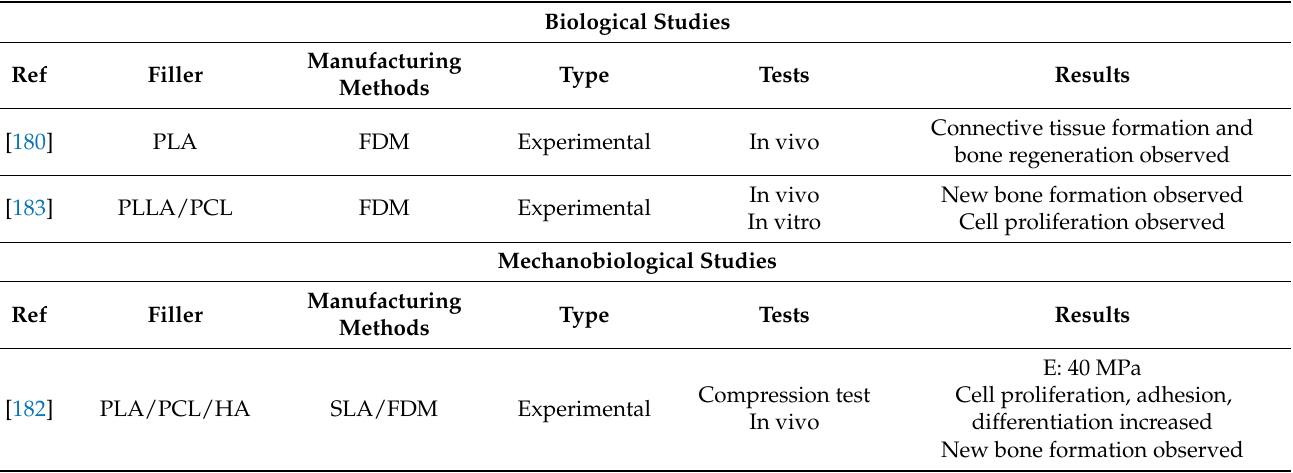
Table 10. Mechanobiological literature of PGA and its composite material; C: compressive strength, T: tensile strength, D: displacement, Y: yield strength, E: modulus of elasticity, WCA: water contact angle, B: bending strength, R: